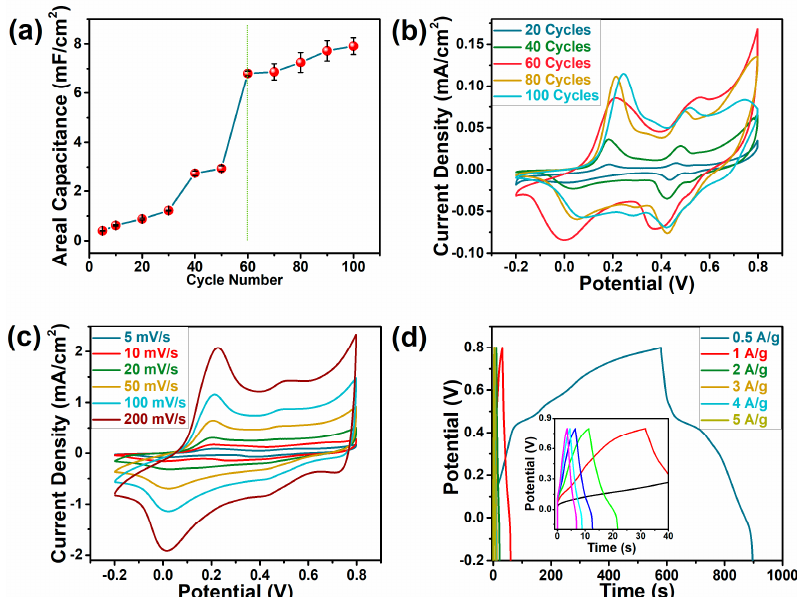
Figure 4. Electrochemical properties of CPP composite hydrogels with different deposition cycles. ( a ) The effect of the deposition cycle on the areal capacitance of CPP composite hydrogel; ( b ) CV curve of CPP composite hydrogels with different deposition cycles at 5 mV/s; ( c ) CV curve of the hydrogel prepared with 60 deposition cycles (CPP-60) at 5–200 mV/s; ( d ) galvanostatic charge–discharge (GCD) curve of CPP-60 at 0.5–5 A/g.